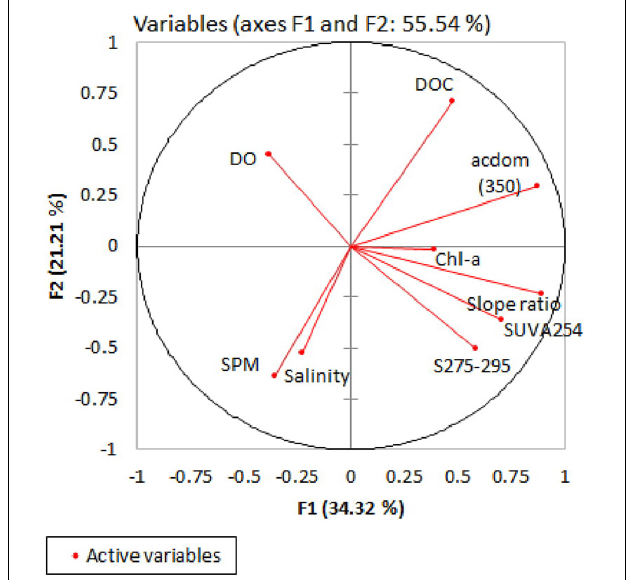
FIGURE 8 | Graphical representation of PCA results for the input variables.